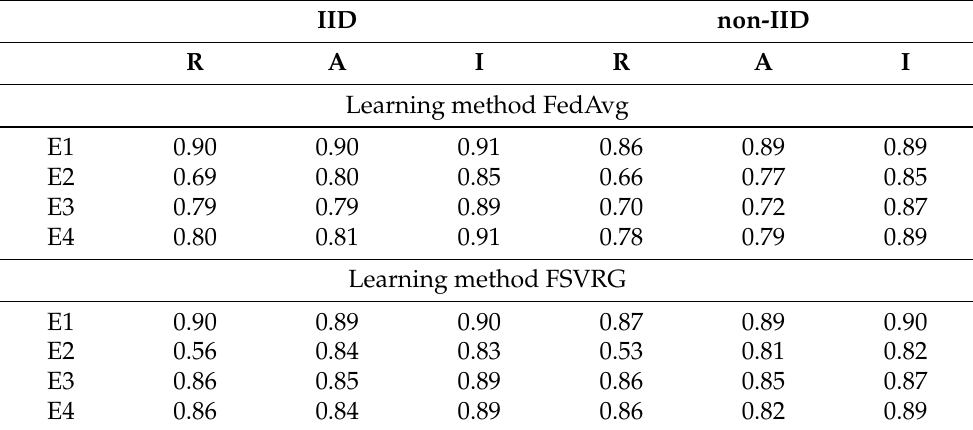
Table 8. Classification accuracies for dataset